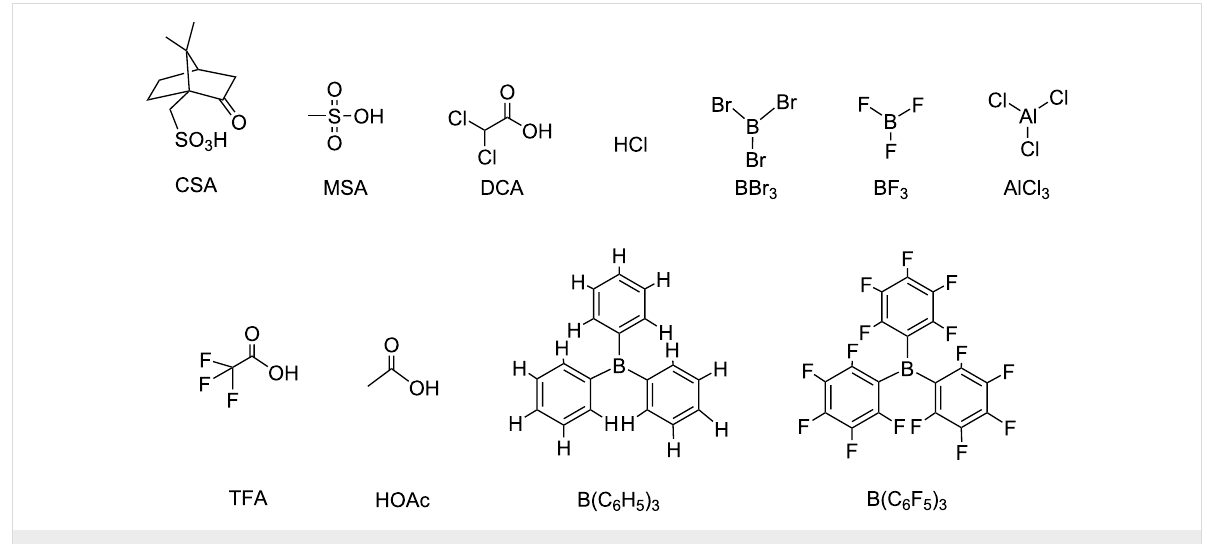
Figure 1: Chemical structures of Lewis acid